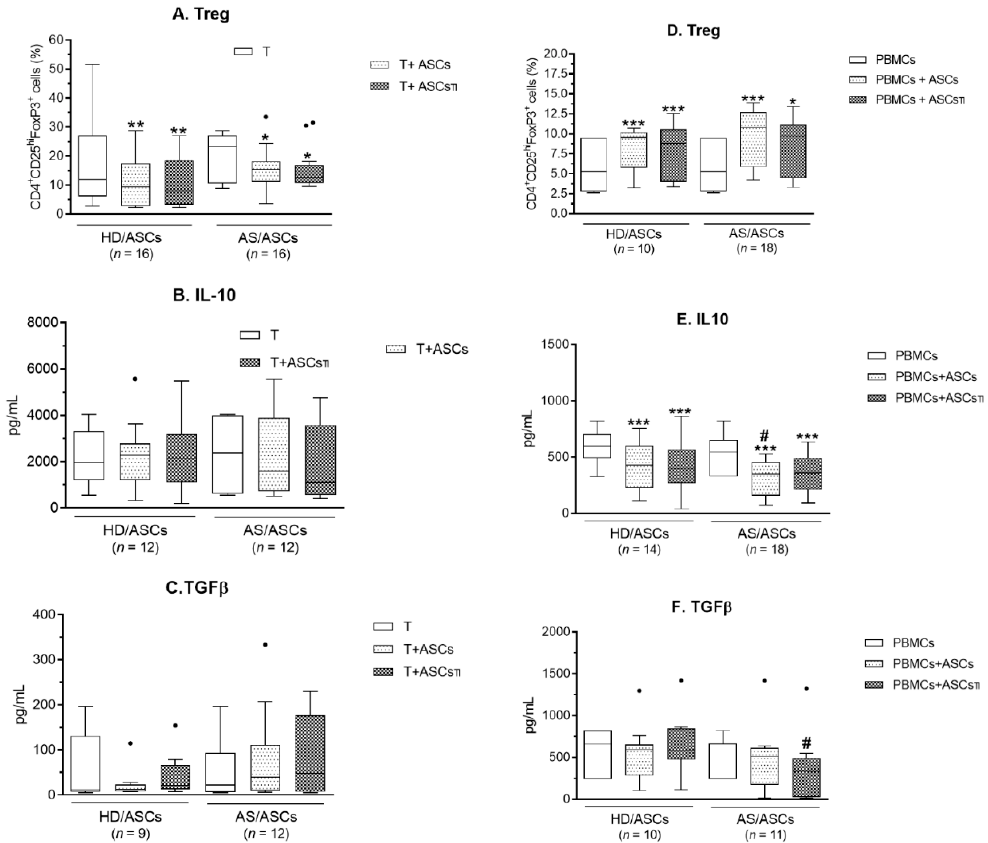
Figure 4. The effects of ASCs on Treg generation and secretion of anti-inflammatory cytokines. Cells were prepared and co-cultured as described in Figures 1 and 2. For T cell-ASCs co-cultures, CD4 + T lymphocytes isolated from peripheral blood of 16 healthy volunteers were randomly combined with 5 HD/ASCs or 16 AS/ASCs lines, while for PBMCs-ASCs co-cultures the number of donors of PBMCs, HD/ASCs, and AS/ASCs was 20, 5, and 18, respectively. The number of Treg ( A , D ) cells was estimated and the concentrations of IL-10 ( B , E ) and TGF β ( C , F ) in culture supernatants were measured by specific ELISAs as described in the Material and methods. Results are expressed as the median (horizontal line) with interquartile range (IQR, box), lower and upper whiskers (data within 3/2xIQR), and outliers (points/dots) (Tukey’s box); n —number of experiments performed. * p < 0.05; ** p < 0.001; *** p < 0.0001 for intra-group comparison. # p < 0.05 for inter-group comparison.